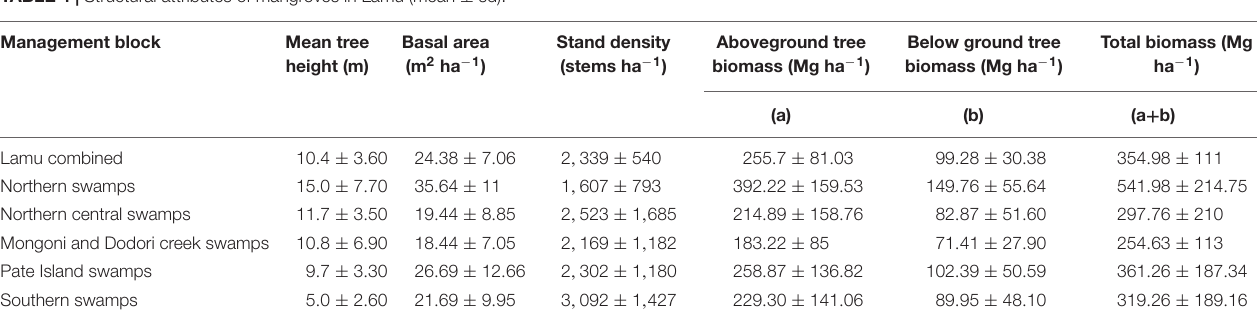
FIGURE 5 | Size class distribution in the blocks of Lamu mangroves (A–E) , and the combined ecosystem (F) . A typical reversed – J curve was witnessed in all management blocks which is an indicator of non-even aged forests with natural recruitment. TABLE 4 | Structural attributes of mangroves in Lamu (mean ±